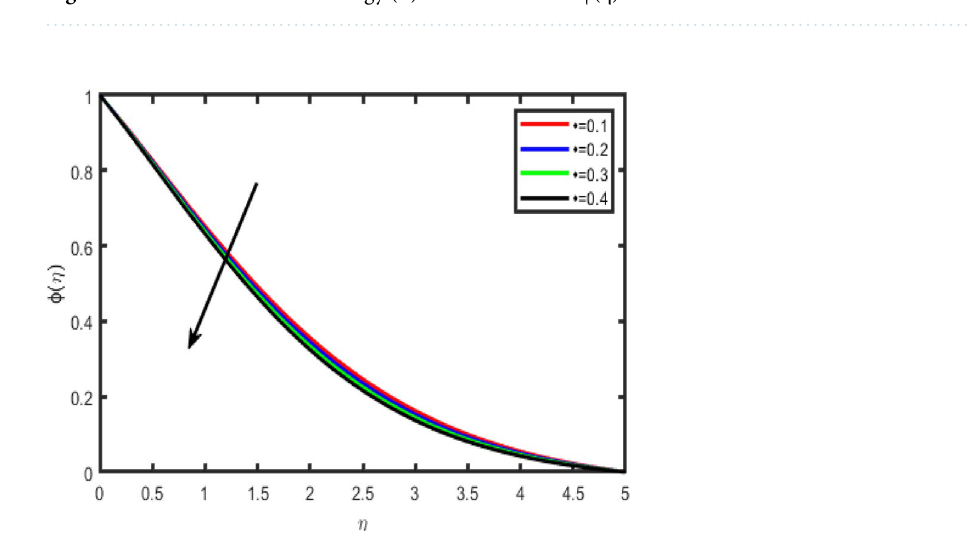
Figure 27. Effect of chemical reaction rate on concentration